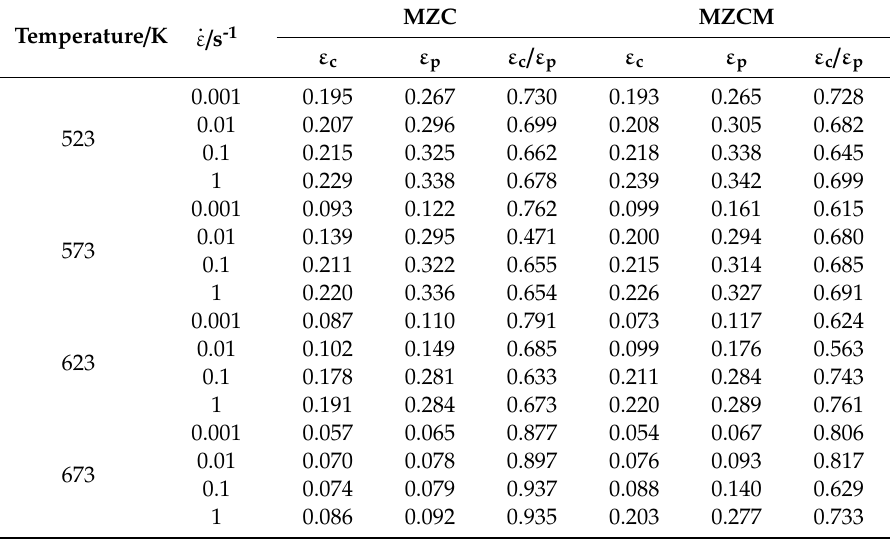
Table 4. Values of ε c , ε p and ε c / ε p under di ff erent deformation conditions for MZC and MZCM. Temperature /